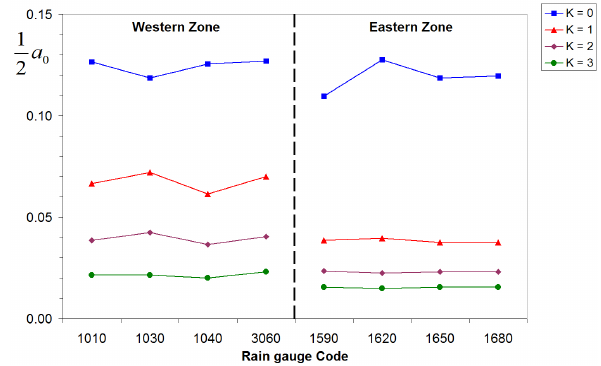
Fig. 6. Evaluation of a 0 (cid:14) 2 for each analysed rain gauge and thresh- old